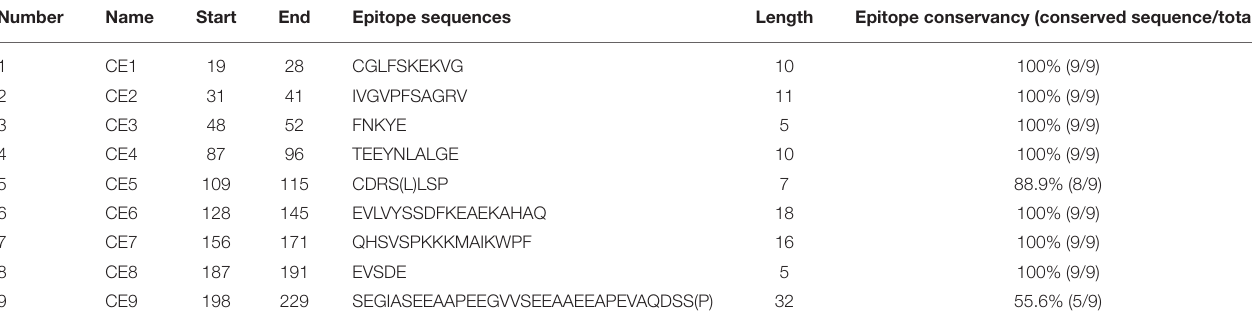
TABLE 4 | B-cell conformational epitopes of the OmpA protein of Anaplasma marginale predicted using BepiPred 2.0 and CBTope and epitope conservancy result.